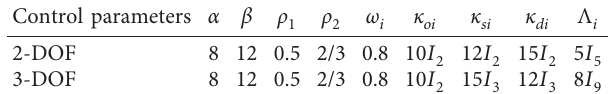
Table 1: Control parameters of EBHC algorithms I and II.